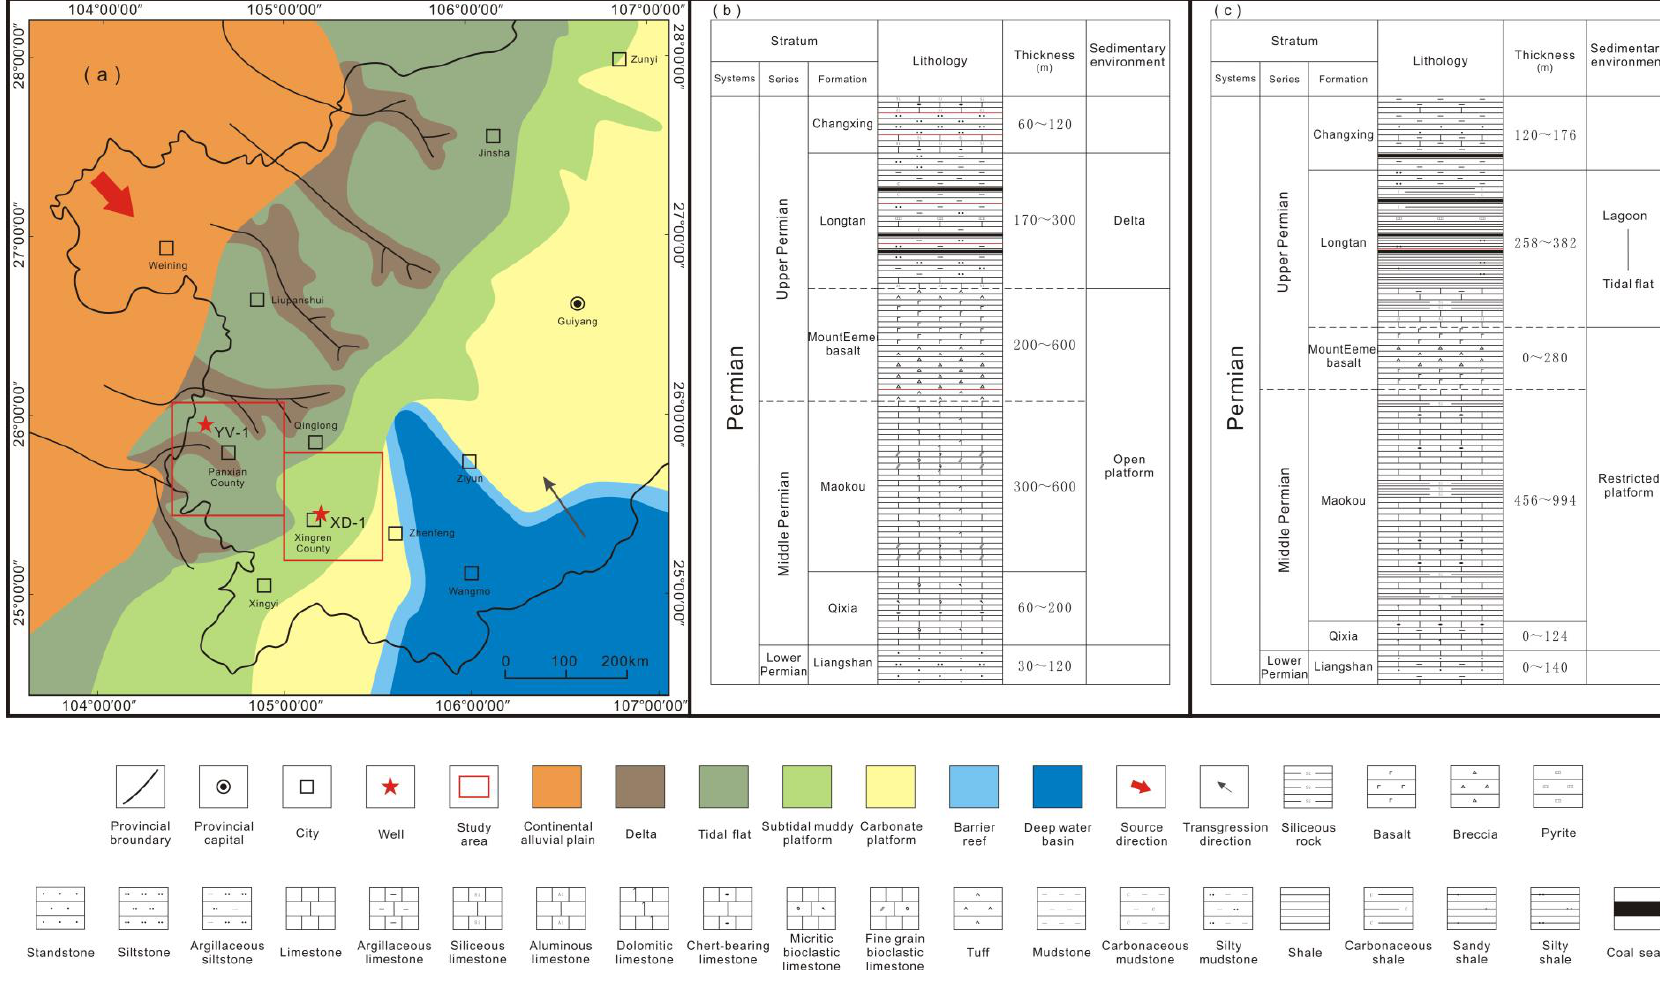
Figure 2. ( a ) Sedimentary facies in southwest Guizhou Province, modified from Dou et al. [29]; ( b ) stratigraphy in Panxian County; ( c ) stratigraphy in Xingren